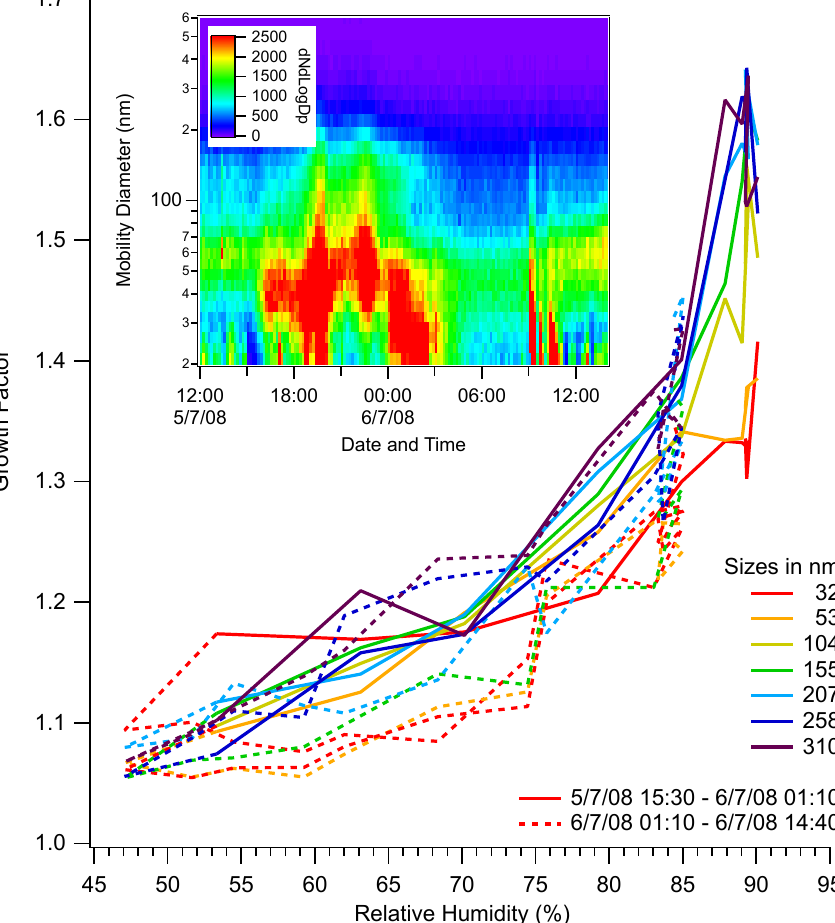
Fig. 6. A humidogram taking during a Terrestrial sector during OP3-III. The solid and dashed lines indicate the evening and morning measurement; roughly corresponding to the measurement of the efflorescence and deliquescence branches respectively. Note: data RH < 45% were unavailable.